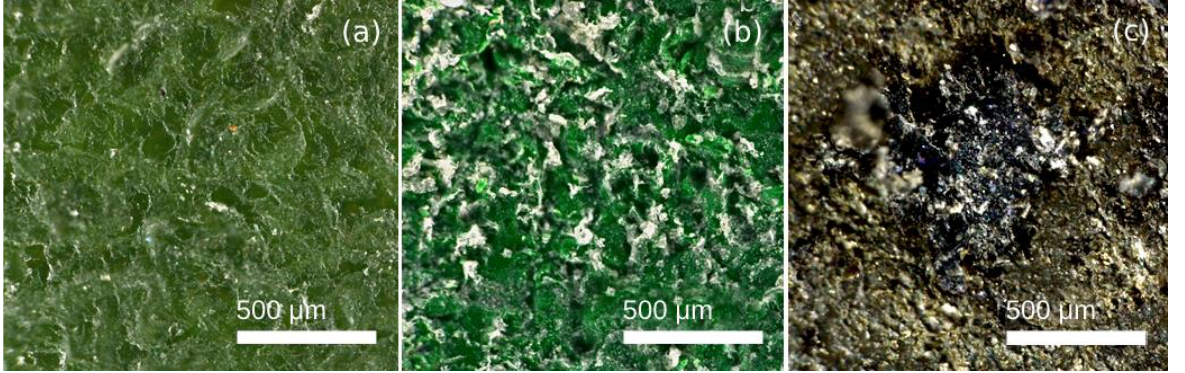
Figure 12. 3D topographic captures (×20 confocal lens, Leica DCM8 high-definition microscope) of the coatings after projection of 4 s with plastic particles at 0.4 MPa: ( a ) PFA, ( b ) FEP, and ( c ) PTFE. Finally, a summary of the results on the effect on scratch resistance after cumulative projection for 0, 4, 8, and 12 s of polymeric abrasive is presented in Figure 13. Figure 13. Evolution of the scratch resistance (N) shown by PFA, PTFE, and FEP after 0, 4, 8, and 12 s wear processes via the projection of plastic-polymer particles at 0.4 MPa.